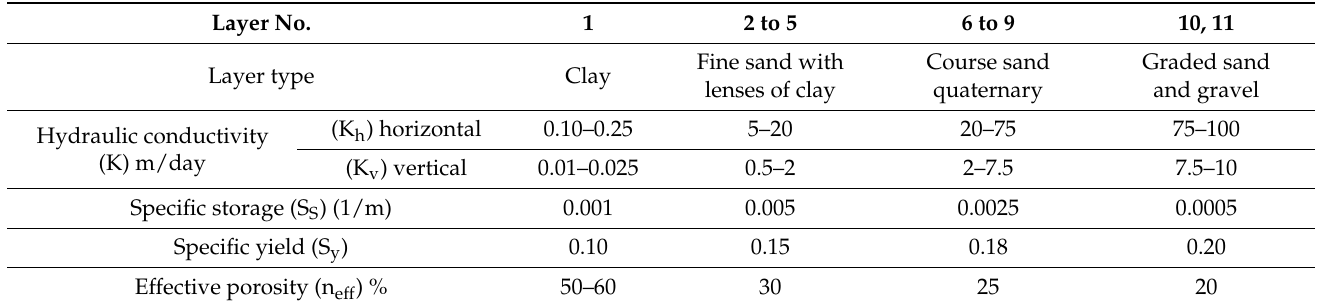
Table 1. Hydraulic parameters of the